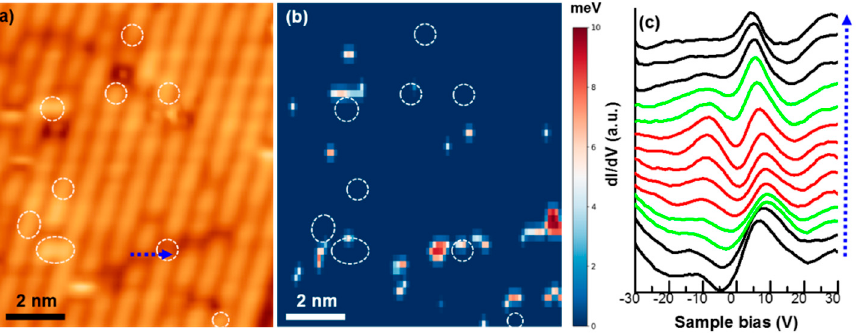
Figure 3. ( a , b ) STM image and superconducting gap map respectively extracted from CITS measurement at 4.2 K on the surface area, as shown Figure 2a ( V S = − 10 mV, It = 200 pA, V ac = 0.5 mV, f = 973 Hz, T = 4.2 K). The white dashed rings mark the position of Pr dopants, as found on the dI/dV map in Figure 2b. The distortion of the image compared with Figure 2 is due to the thermal drift of 15 h CITS. ( c ) dI/dV line spectra taken across a superconducting phase area marked by the blue arrow in ( a ). The spatial distance between each taken curve is 0.12 nm. Red and black mark the superconducting density of states and normal metallic density of states, respectively. The transition curves from the superconducting density of states to the normal metallic density of states have pseudogap characteristics, which are marked with a green color. Vertical offsets are applied to the spectra for clarity.